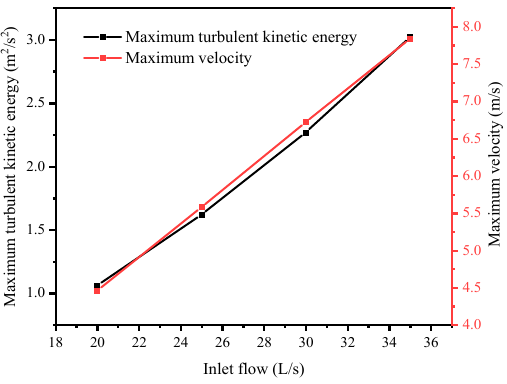
Figure 8. Maximum turbulent kinetic energy and dynamic axial velocity under four flow rates.